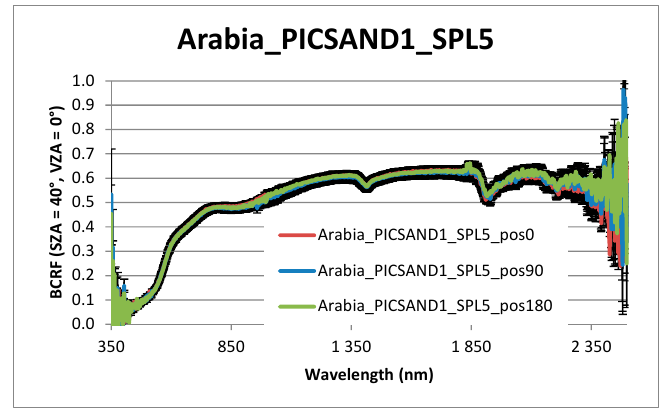
Figure 3. Measurements discrepancy for the three positions compared to one measurement (pos0) uncertainty for Arabia_PICSAND1_SPL5 .